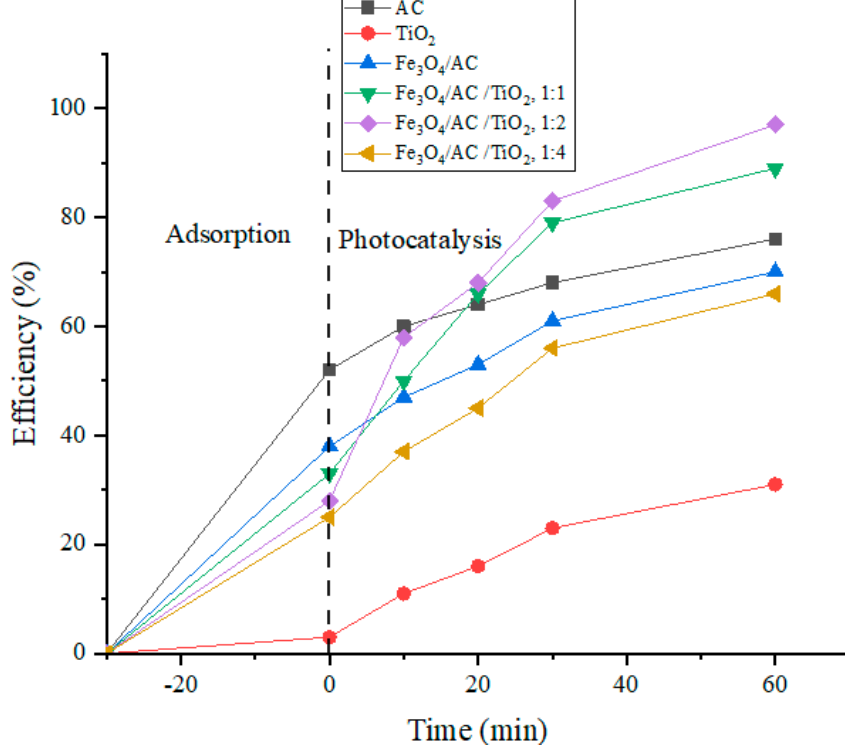
Figure 7. Methylene blue (MB) removal efficiencies over catalysts (AC, TiO 2 , Fe 3 O 4 /AC, Fe 3 O 4 /AC/TiO 2 (1:1, 1:2, 1:4)) under UV light.